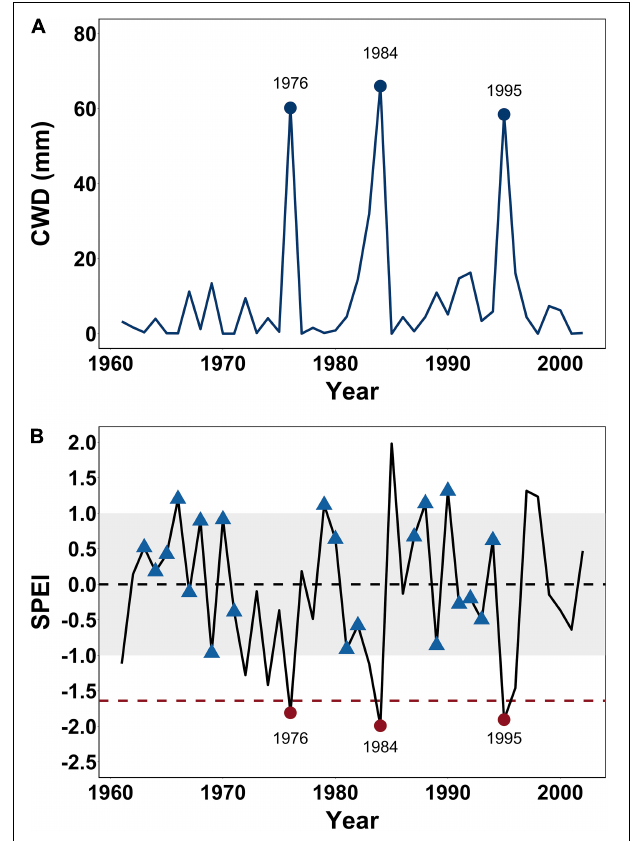
FIGURE 1 | (A) Annual climatic water defect (CWD in mm) summed over 6 months (March – August) for each year during the study period (1961–2002). (B) Annual Standardized Precipitation Evapotranspiration Index (SPEI) values calculated over the same study period (1961–2002). The gray band indicates typical climate years ( < 1 and > –1). The horizontal red dashed line at an SPEI of –1.64 reflects the threshold for drought linked growth decline in pine species proposed by Huang et al. (2015). The three droughts (1976, 1984, and 1995) considered in this study are indicated by red filled circles and annotated in both (A,B) while blue triangles indicate the years used to calculate the pre-drought growth averages.